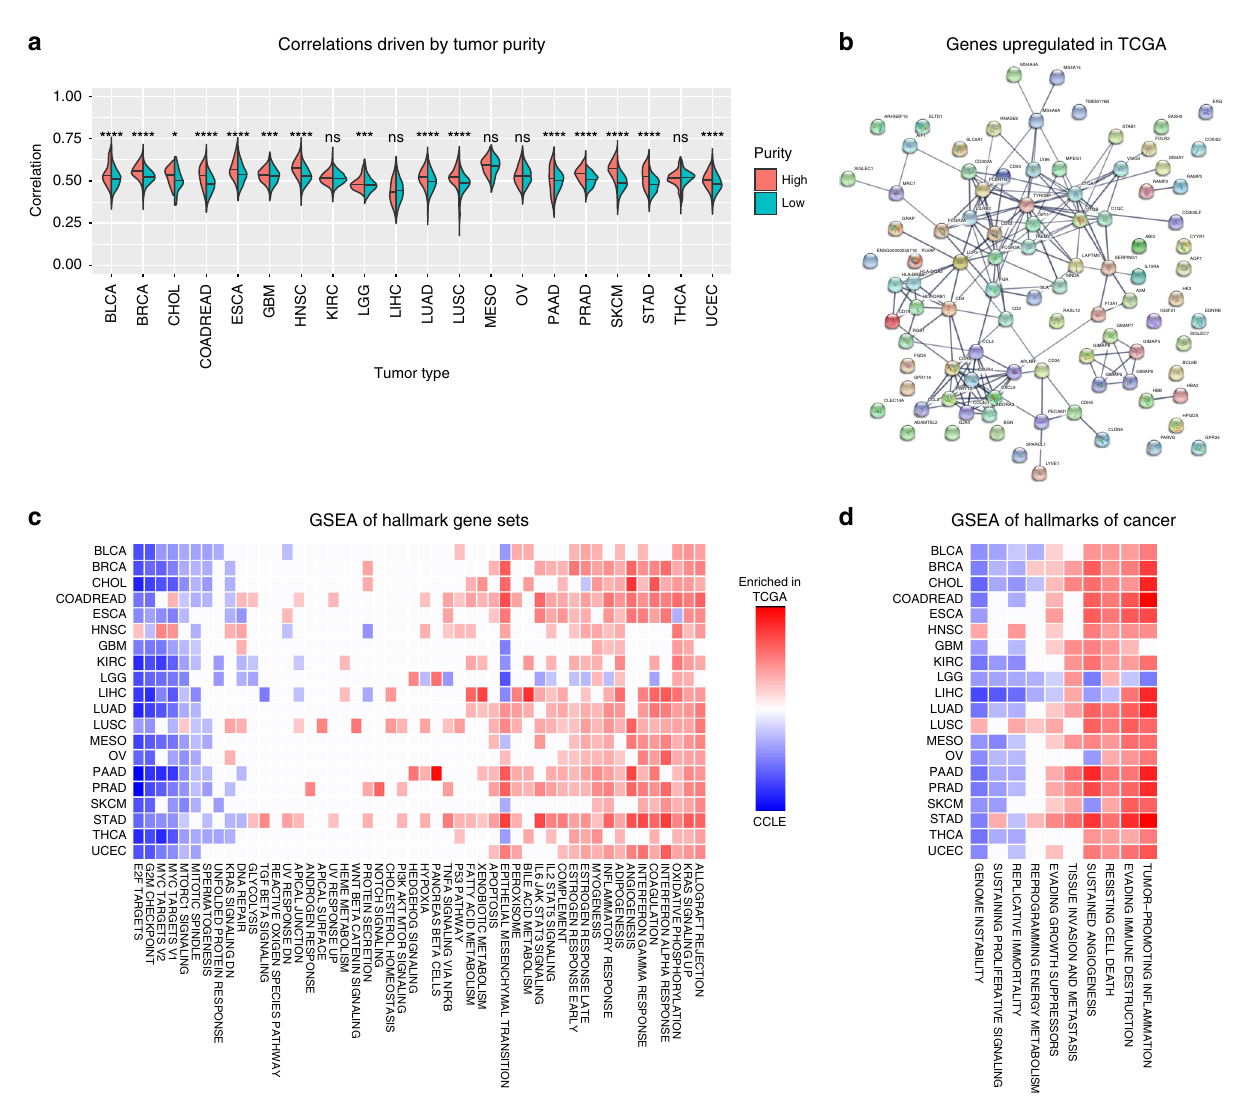
Fig. 2 Primary tumor sample/cell line correlations driven by tumor purity. a Correlations between cell lines and high purity primary tumor samples (red) are signi fi cantly higher than correlations between cell lines and low purity primary tumor samples (turquoise) in 15/20 tumor types using the one-sided Wilcoxon test. P -values are indicated by symbols above the violin plots with ns corresponding to p -value > 0.05, one star corresponding to p -value < = 0.05, two stars corresponding to p -value < = 0.01, three stars corresponding to p -value < = 0.001, and four stars corresponding to p -value < = 0.0001. The median correlation coef fi cients are depicted by the horizontal black lines in the violin plots. b STRING analysis of protein – protein interactions for the 95 genes upregulated in primary tumor samples in all 20 of the analyzed tumor types (PPI enrichment p -value < 1.0e-16). Line thickness denotes con fi dence of the interaction, and only high con fi dence interactions are shown. The PPI network is enriched for immune response pathway genes (false discovery rate = 5.51e-06). c Gene Set Enrichment Analysis (GSEA) between primary tumor samples and cell lines using hallmark gene sets from MSigDB. NES are shown for pathways with FDR < 5%. Blue boxes indicate enrichment in cell lines, and red boxes indicate enrichment in primary tumor samples. Gene sets related to cell-cycle progression are enriched in cell lines across tumor types, and immune pathways are enriched in primary tumors. d GSEA of hallmarks of cancer pathways. Genome instability is enriched in cell lines across all tumor types, and tumor-promoting in fl ammation is enriched in primary